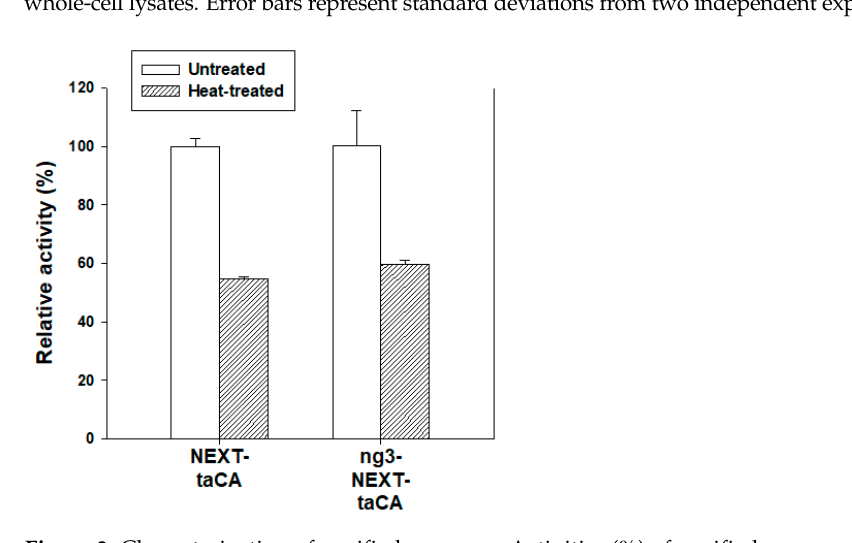
Figure 3. Characterization of purified enzymes. Activities (%) of purified enzymes normalized by the activity of untreated NEXT-taCA are presented before and after heat treatment at 80 °C for 12 h. Error bars represent standard deviations from two independent experiments.